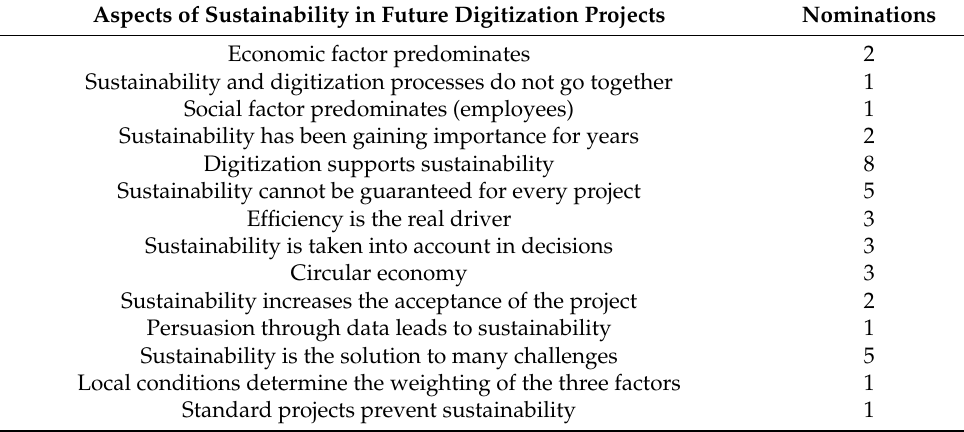
Table 8. Sustainability aspects in future digitization projects ( n =